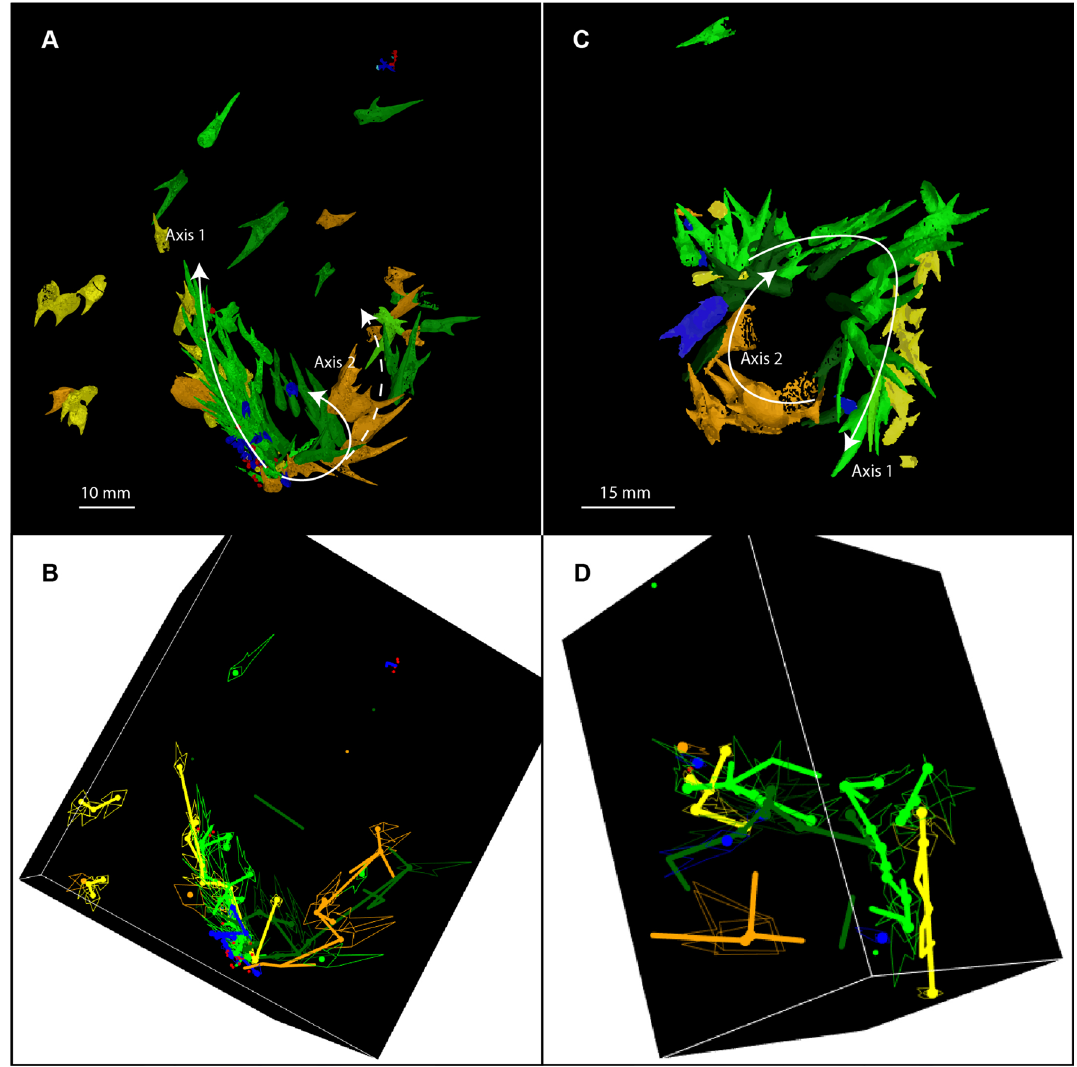
Figure 3. Distribution of the hooks in-situ in Rhaeboceras halli . ( A ) & ( B ) AMNH 66350. ( C ) & ( D ) AMNH 66433. ( A ) & ( C ) 3D rendering (VGStudio MAX 3.0.) of the structures preserved in the body chamber. ( B ) & ( D ) Simplified representation of the distribution of the hooks in space (R software, package rgl 65 ). The thick lines represent the links between the hooks according to morphotype, based on the persistent homology analysis of the centroid position of their opening. Only the strongest and best integrated links are shown. The white arrows indicate the two suspected axes. Additional animated figure is available in the corresponding supplementary “.gif” document and interactive plot is available in the corresponding supplementary “.html”